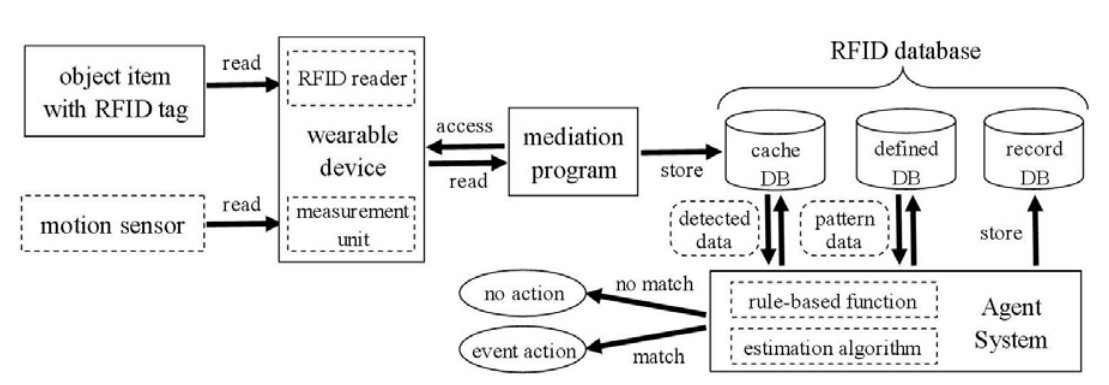
Figure 4. Block diagram of the management